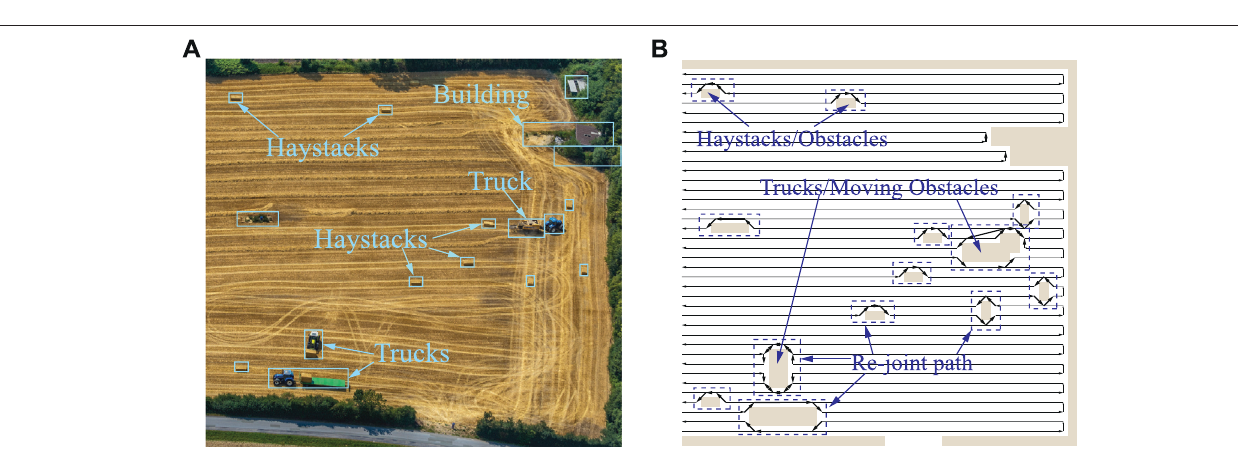
Frontiers in Robotics and AI |